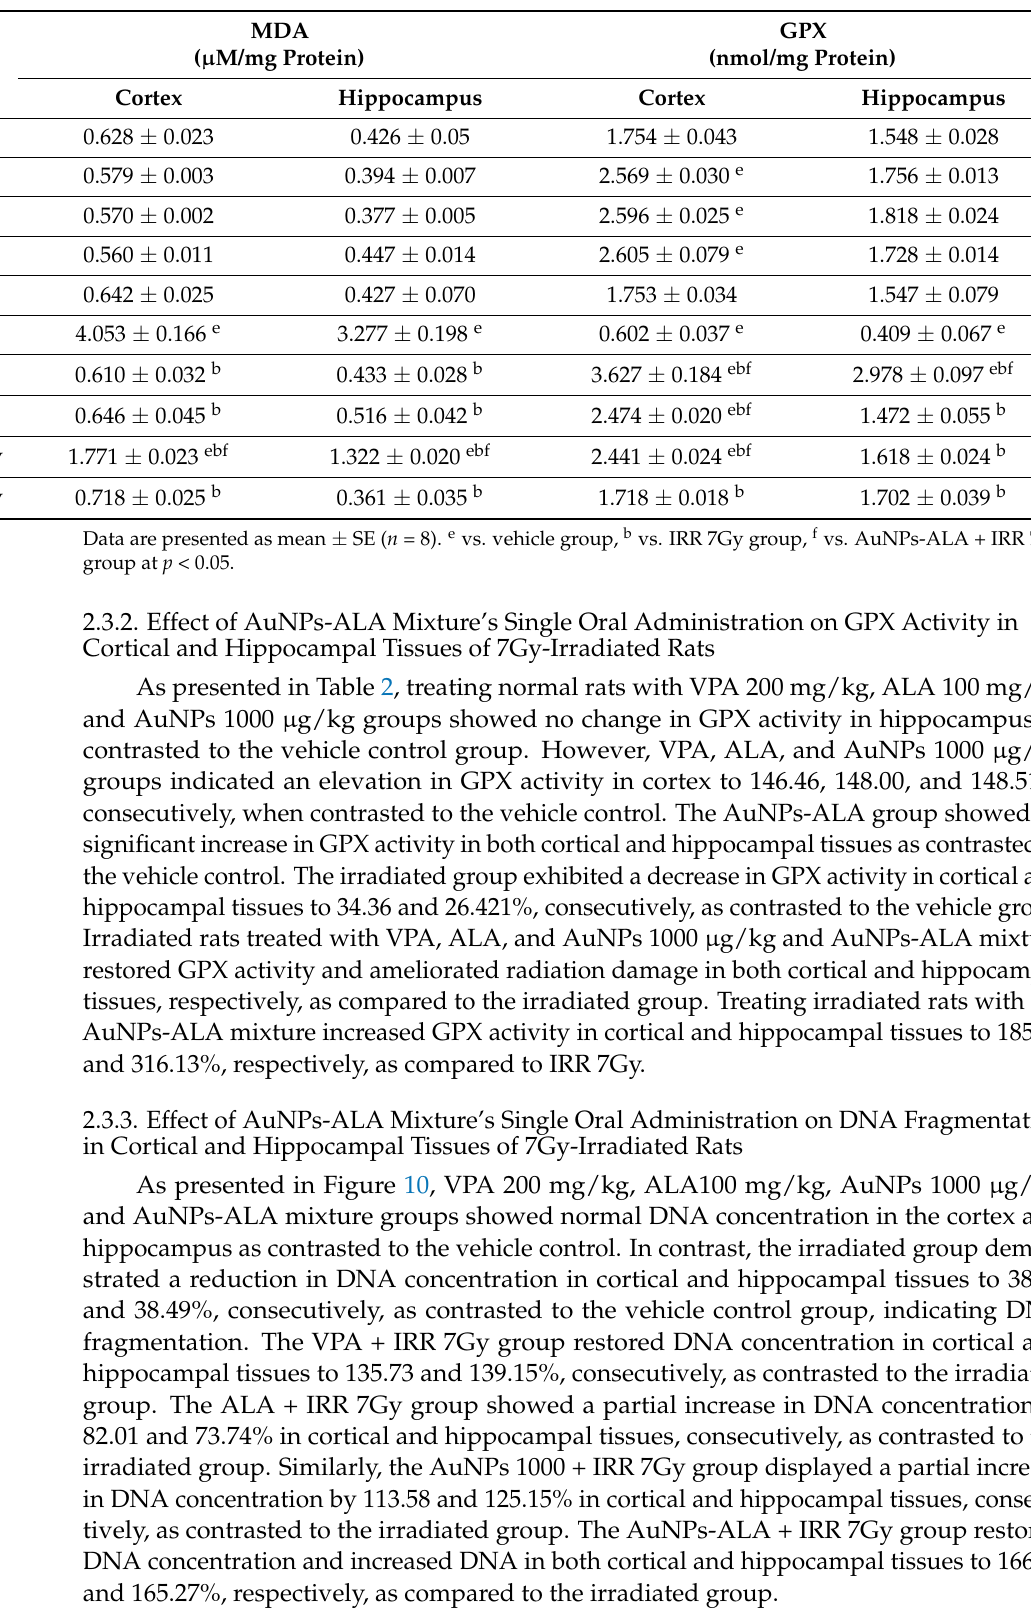
Table 2. Effect of single oral administration of AuNPs-ALA mixture on MDA content and GPX activity in cortical and hippocampal tissues of 7Gy-irradiated